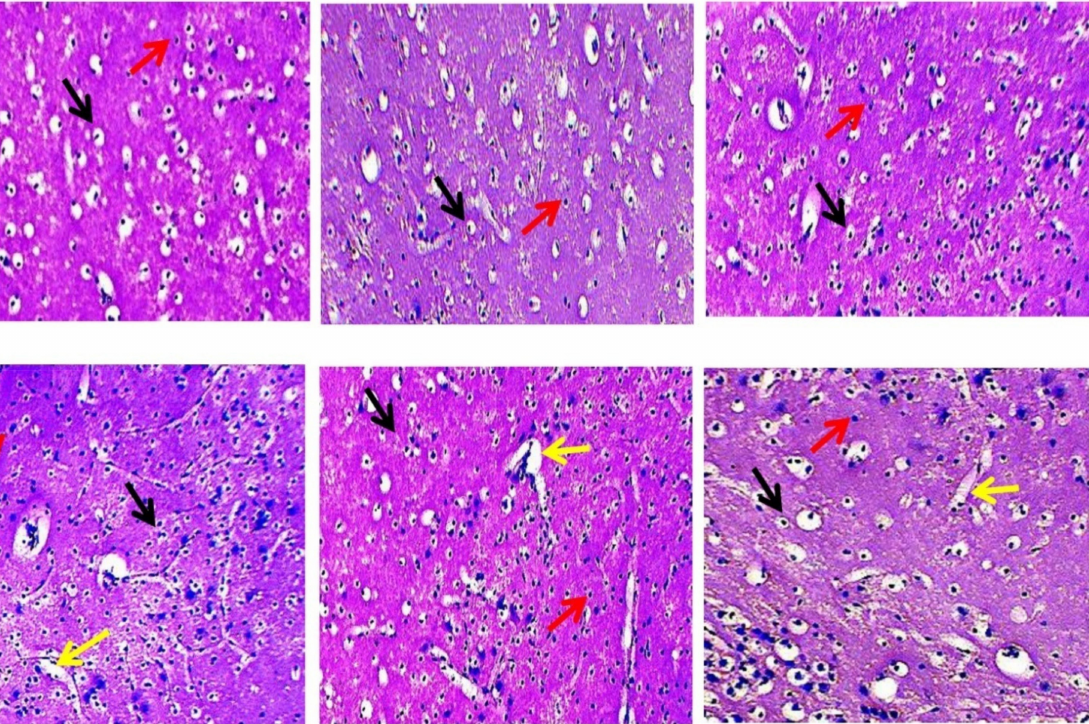
Figure 18. The effect of 4-hydroxyisoleucine on histopathological alterations in rats following methyl mercury exposure. The slides were selected to show neuronal populations stained with hematoxylin and eosin under a fluorescence microscope. Light microphotographs of the cerebral cortex revealed the following morphological changes during MeHg exposure and 4-HI treatment: ‘Section: A’ shows the vehicle group.The black arrows indicate healthy oligodendrocyte cells, mostly found in the cerebral cortex. The red arrow indicates microglia. ‘Section: B’ shows the sham control group, with black arrows indicating healthy oligodendrocyte cells and red arrows signifying microglia. ‘Section: C’ shows the 4-HI-perse-treated group, which exhibits the typical pattern of all neuronal cells, just like the sham control group. ‘Section: D’ depicts a MeHg-treated group with oligodendrocyte degeneration and necrosis, as indicated by the black and yellow arrows, as well as an increase in microglial density (red arrow). ‘Section: E’ represents theMeHg- and 4-HI-(50 mg/kg)-treated group showing regeneration of oligodendrocytes represented by the black arrow, decreased density of microglial cells represented by the red arrow, and recovery of neuronal cells by decreasing the area of necrosis represented by the yellow arrow. ‘Section: F’ depicts the diminished area of necrosis indicated by the yellow arrow in the MeHg- and 4-HI-(100 mg/kg)-treated group, the black arrow represents the restoration of oligodendrocyte, and the red arrow represents reduced microglial